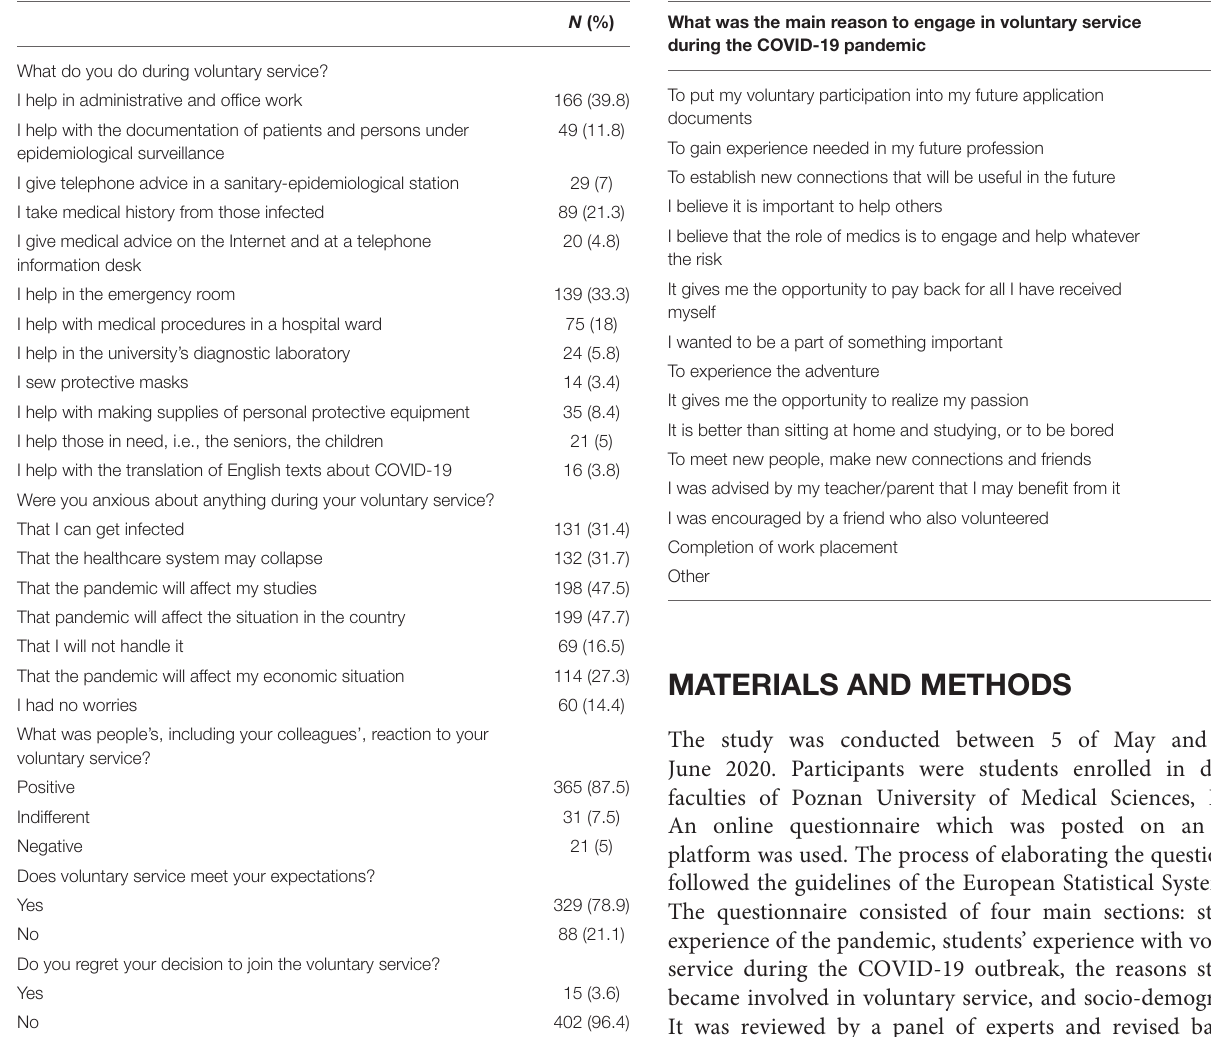
TABLE 3 | Students’ experience with voluntary service during the COVID-19 pandemic.